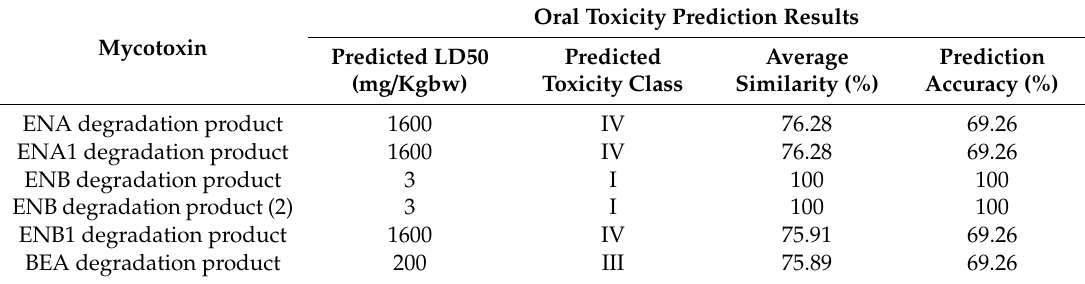
Table 2. Acute oral toxicity prediction obtained by using ProTox-II web server.